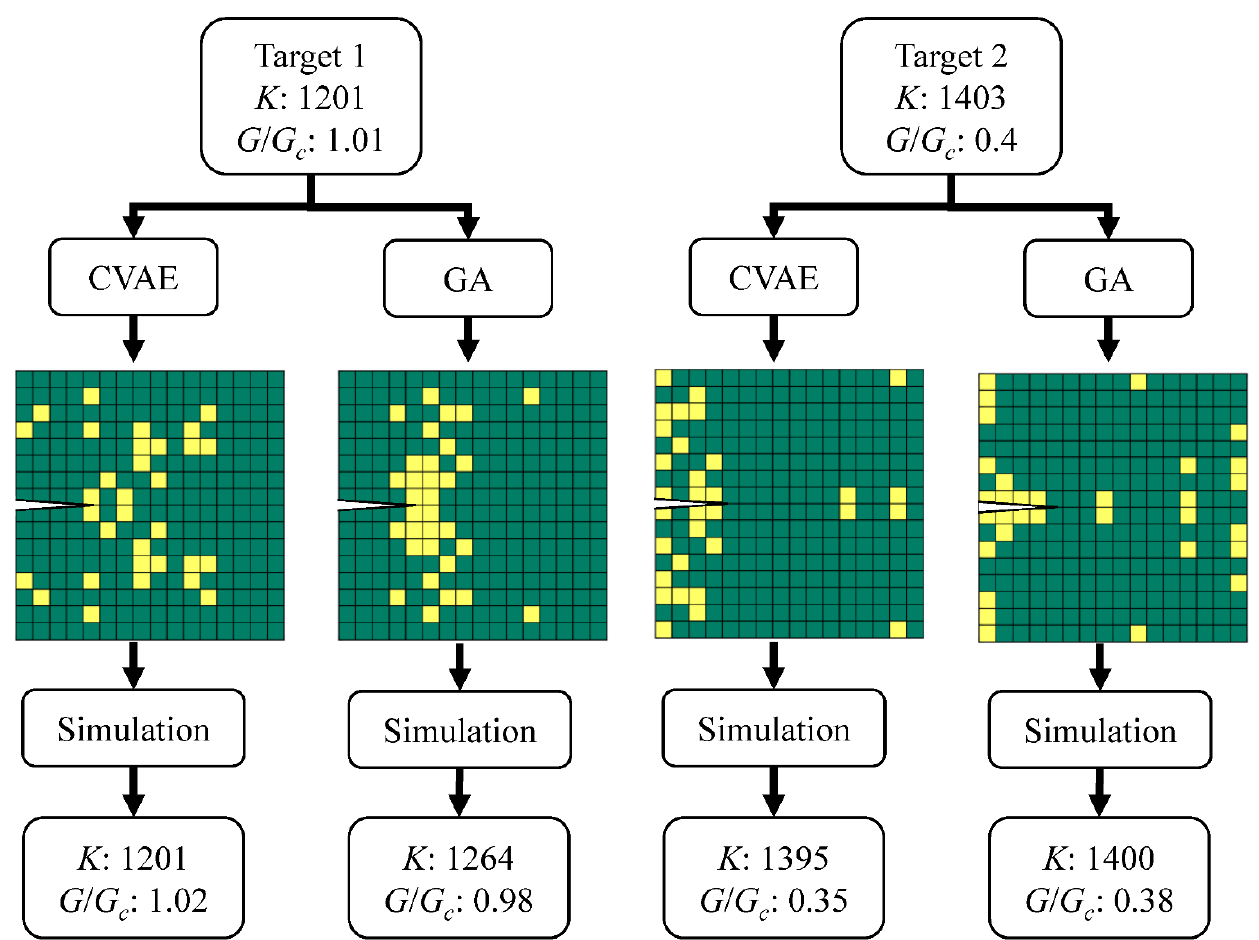
Figure 11. Two examples with different target stiffness and toughness values illustrating the design process and the results of GA and CVAE. The unit of K is